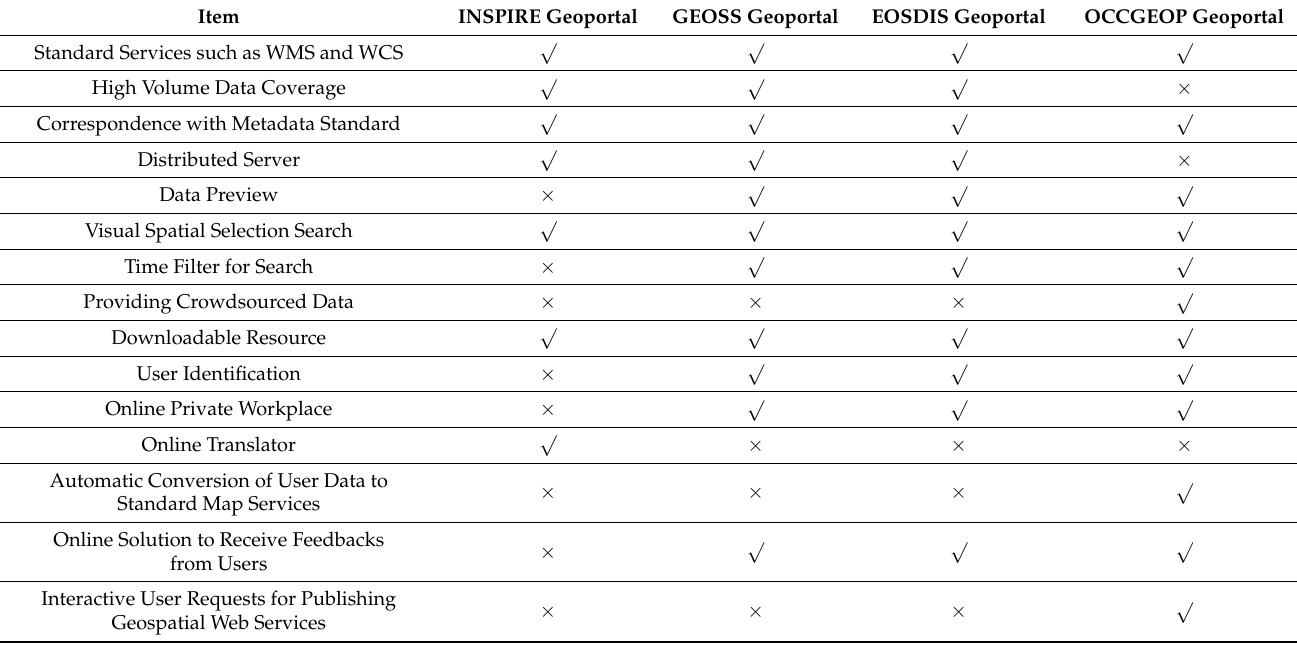
Table 1. Comparative analysis of OCCGEOP vision and capabilities with the three target geoportals. Item INSPIRE Geoportal GEOSS Geoportal EOSDIS Geoportal OCCGEOP